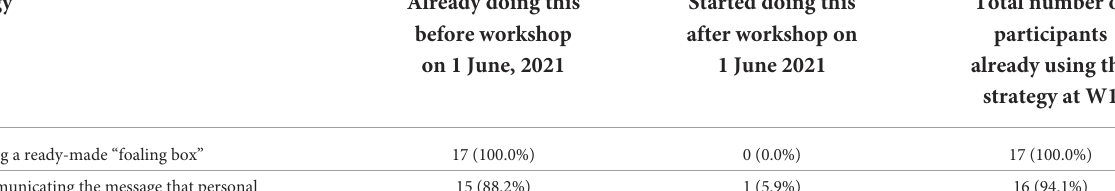
TABLE 5 The 16 strategies already in use at the first survey wave (W1), showing strategies adopted before and after the workshop on 1 June, 2021, ranked from highest to lowest number of participants reporting their usage. Strategy Already doing this